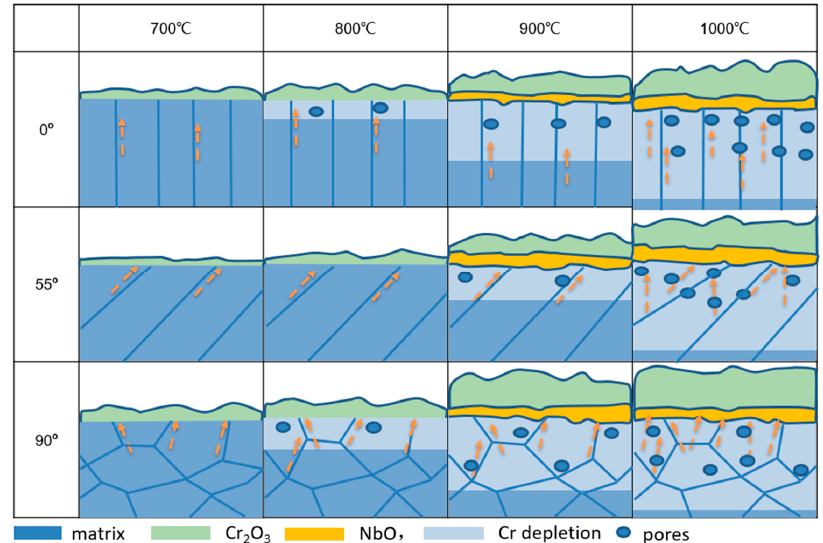
Figure 16. Oxidation mechanisms of EBM-In718 alloys with different build direction in high temperature for 100 h.